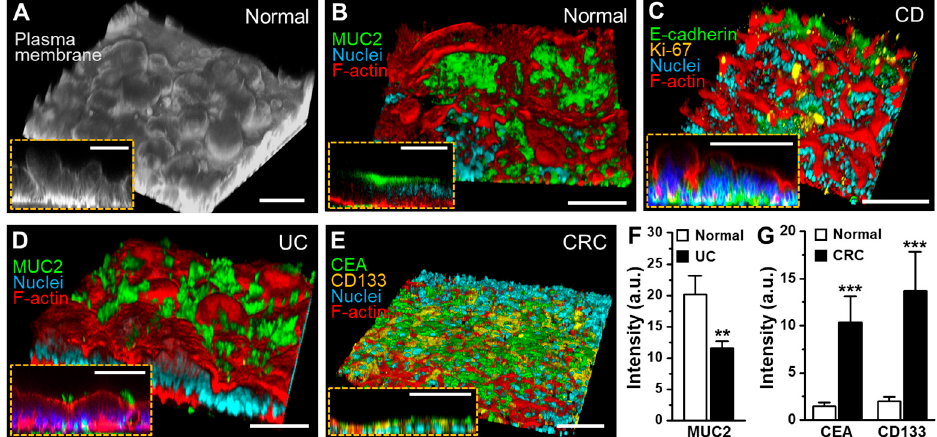
Figure 5. The characterization of the 3D morphology and differentiation of patient-derived organoid epithelium grown in a PMI Chip. The angled views of the 3D epithelial layer derived from ( A , B ) normal, ( C ) CD, ( D ) UC, and ( E ) CRC organoids. The insets in the figures from A to E displays the vertical cross-cut view of each 3D epithelial layer. Various structural (F-actin, E-cadherin), functional (MUC2, Ki-67), or disease-specific markers (CEA, CD133) were highlighted by immunofluorescence staining followed by confocal microscopy. As a counterstaining, nuclei were highlighted in cyan. Bars, 100 µm. The quantitative comparisons of the expression of functional (MUC2) ( F ) and disease-specific markers (CEA, CD133) ( G ) in the normal and the patient-derived organoid epithelium in a PMI Chip. ** P < 0.01, *** P < 0.001.